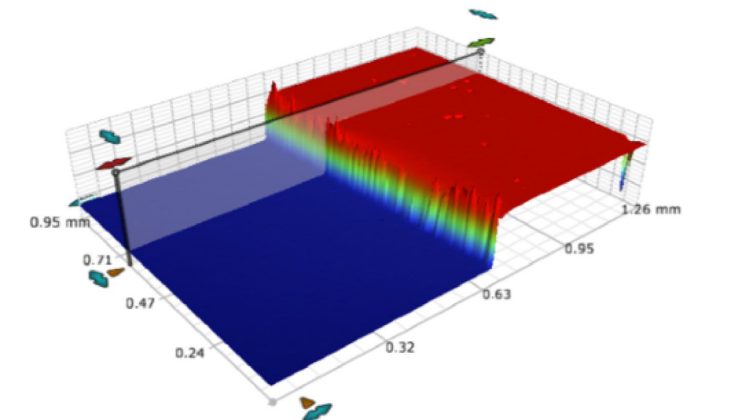
Figure 4. Example of 3D profilometer image of coating (Ti,Al,Si)N